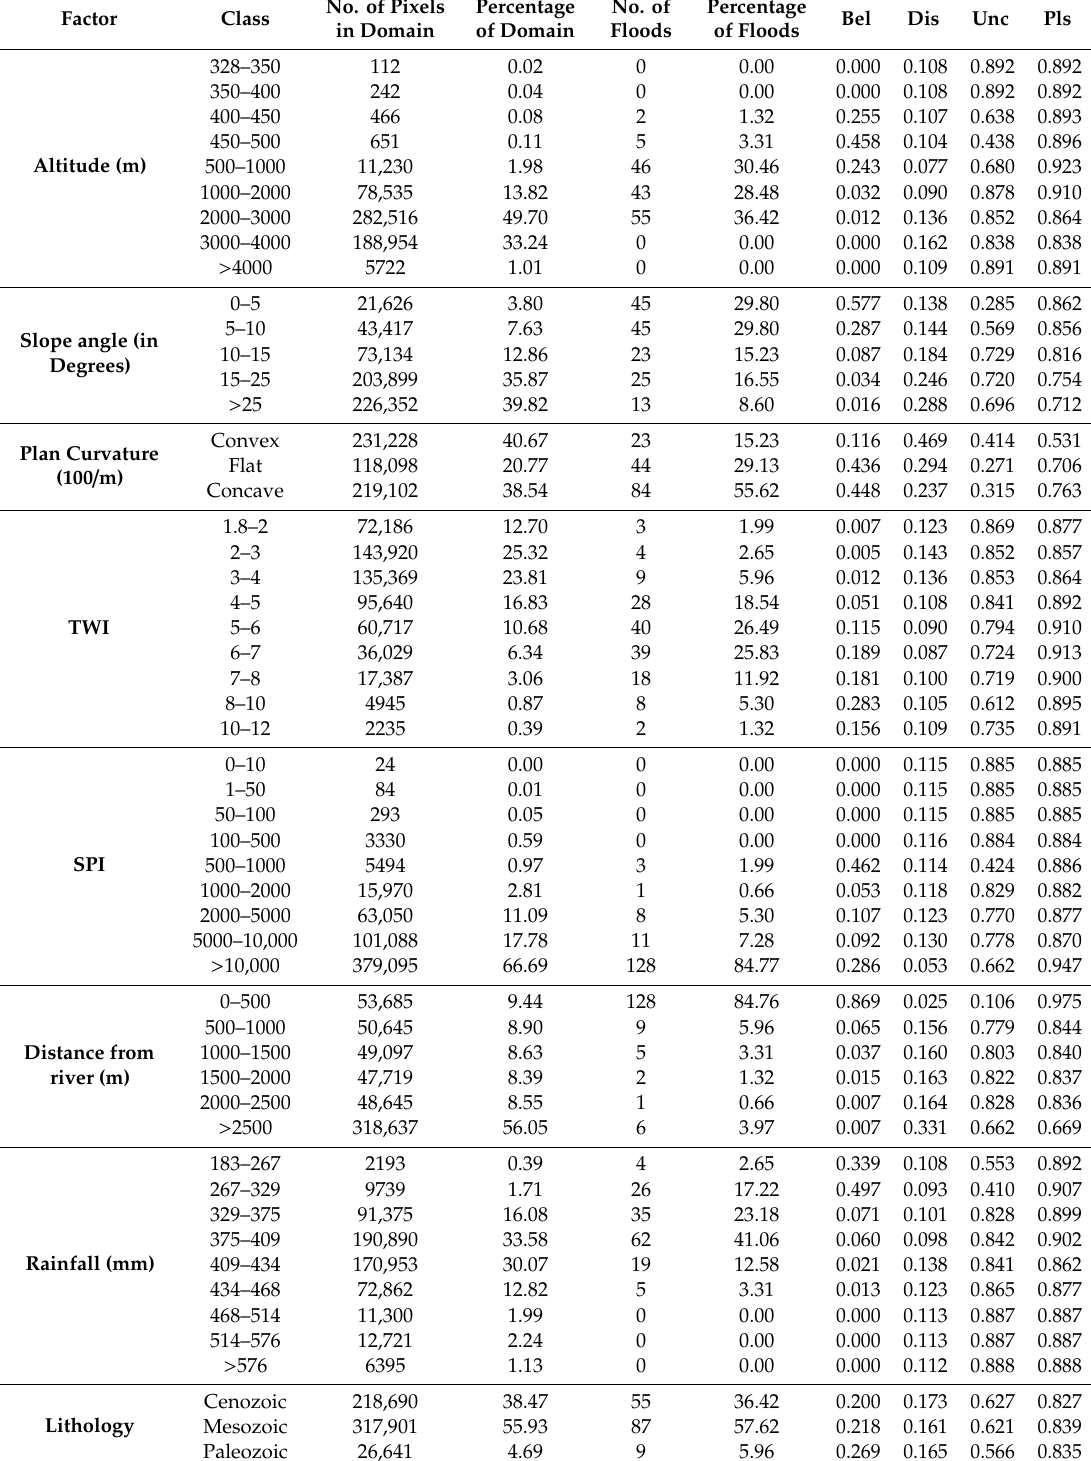
Table 3. Spatial relationships among conditioning factors and flooding occurrence extracted by the EBF